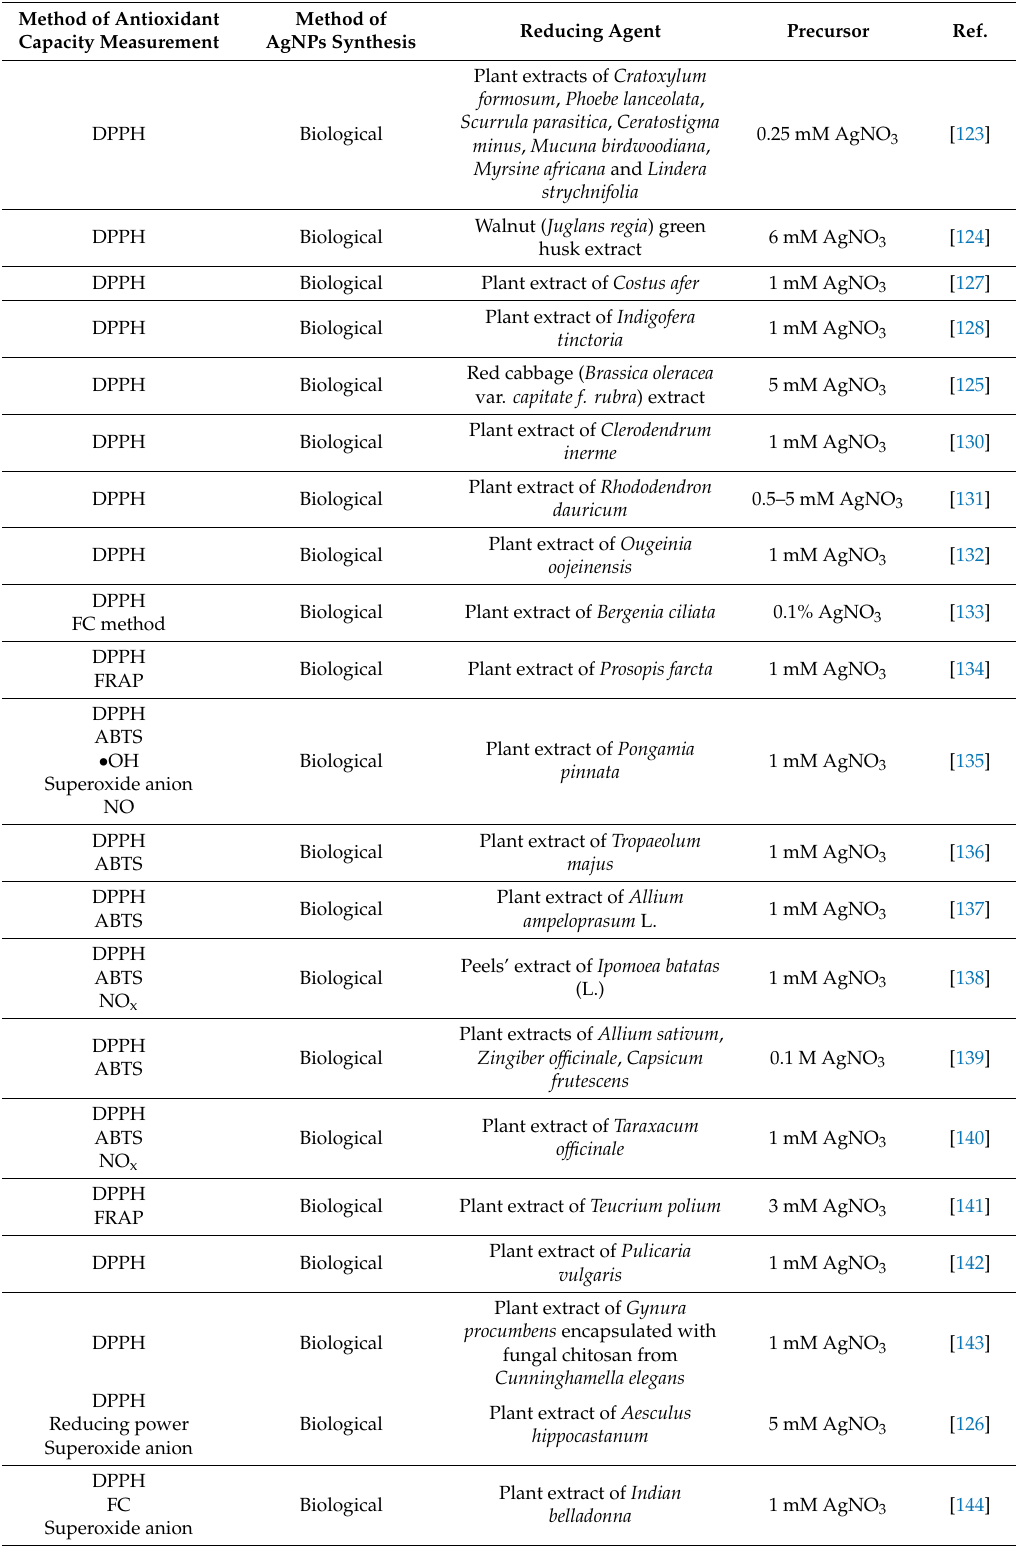
Table 3. Methods of antioxidant capacity determination of prepared silver nanoparticles. Method of Antioxidant Capacity